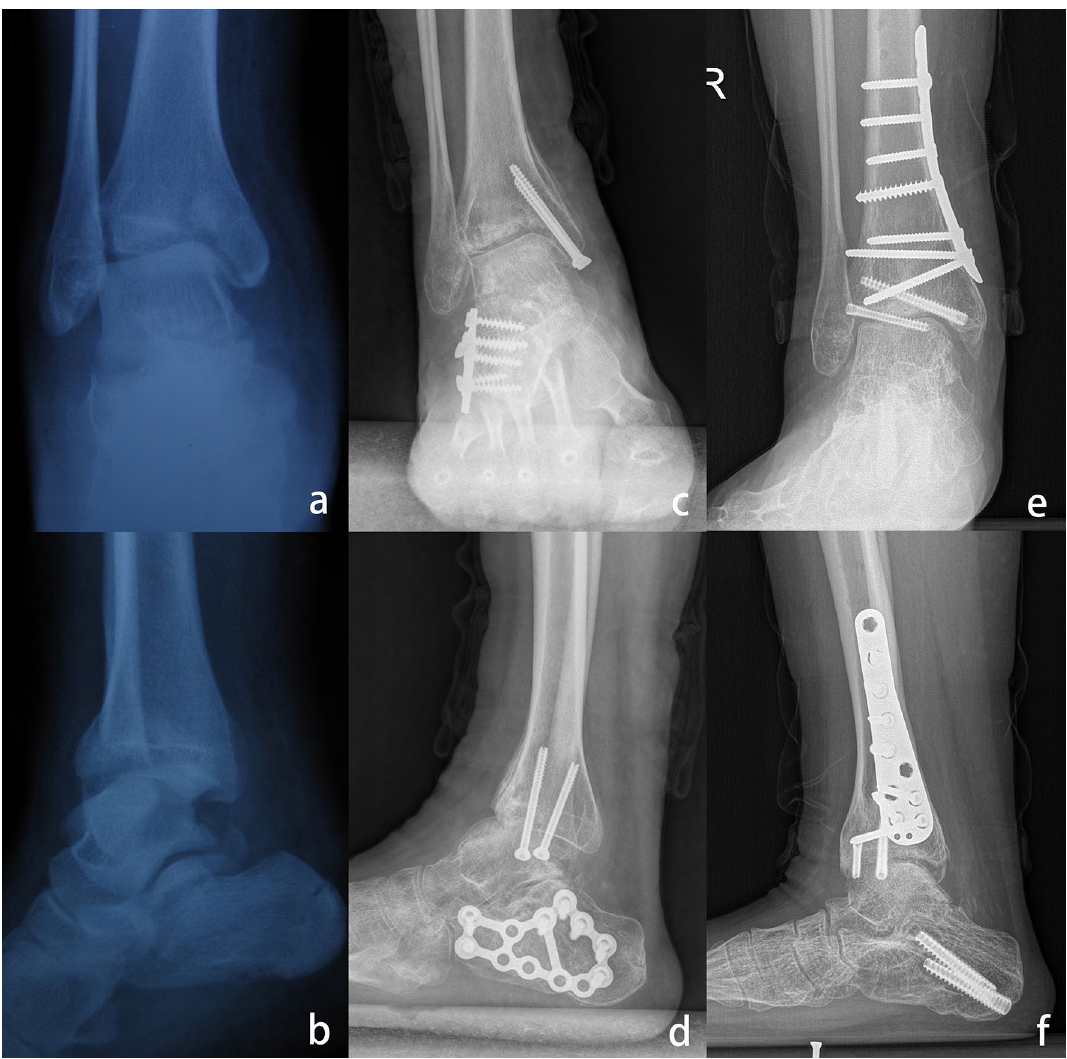
Figure 6. ( a,b ) A 16-year-old girl had a pilon type B ankle fracture and calcaneal fracture. ( c,d ) Open reduction and internal fixation was performed; however, she developed malunion of the distal tibial plafond fracture. The TAS angle was 74°, and the distal tibial plafond was impacted by anterior translation of the talus. ( e,f ) Corrections on both the sagittal and coronal planes of the distal tibial plafond were performed, with excellent clinical outcomes three years after revision